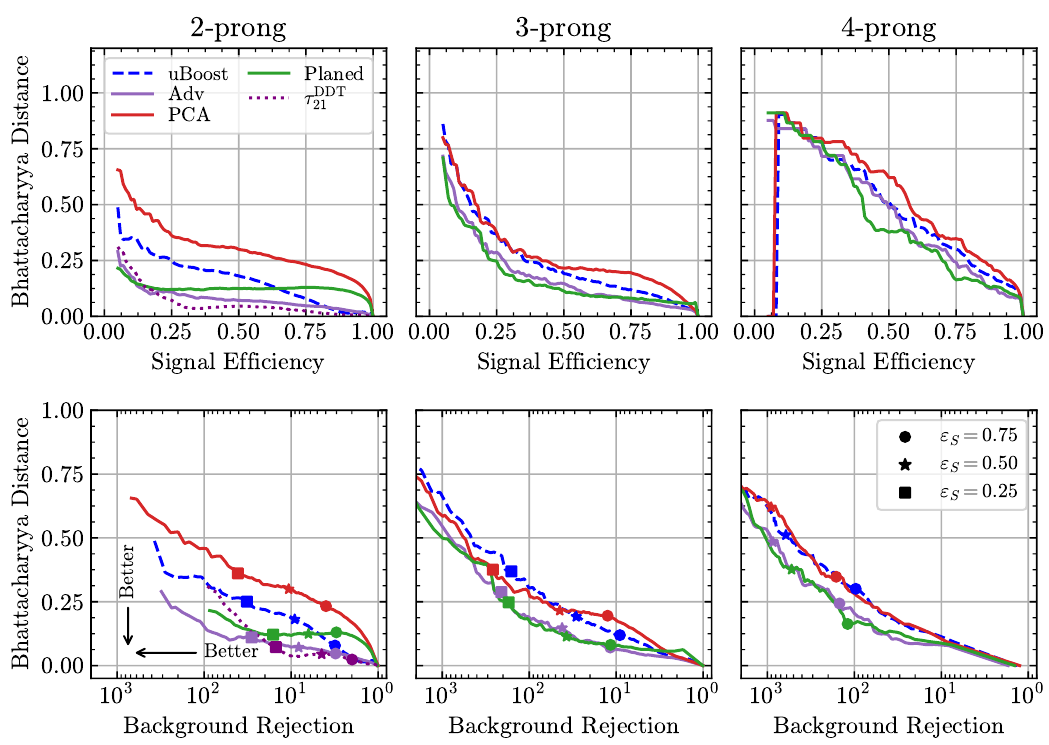
Figure 15: A comparison of all the MV based methods to decorrelate the jet mass from the classifier output. The shown PCA and Planed results are for NN architecture. The analytical τ DDT method sculpts the least for moderate background rejection, but 21